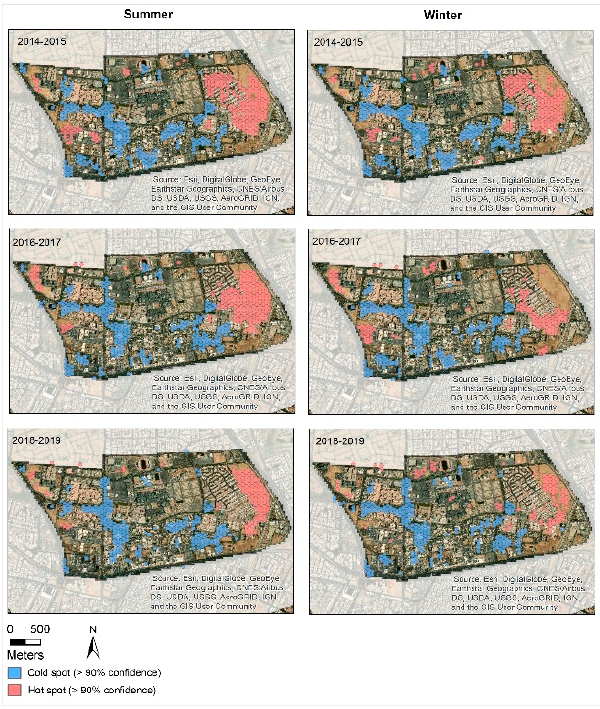
Figure 8. Hot spots and cold spots of bare land (measured according to NDBI) in the summer and winter of 2014–2015, 2016–2017, and 2018–2019.